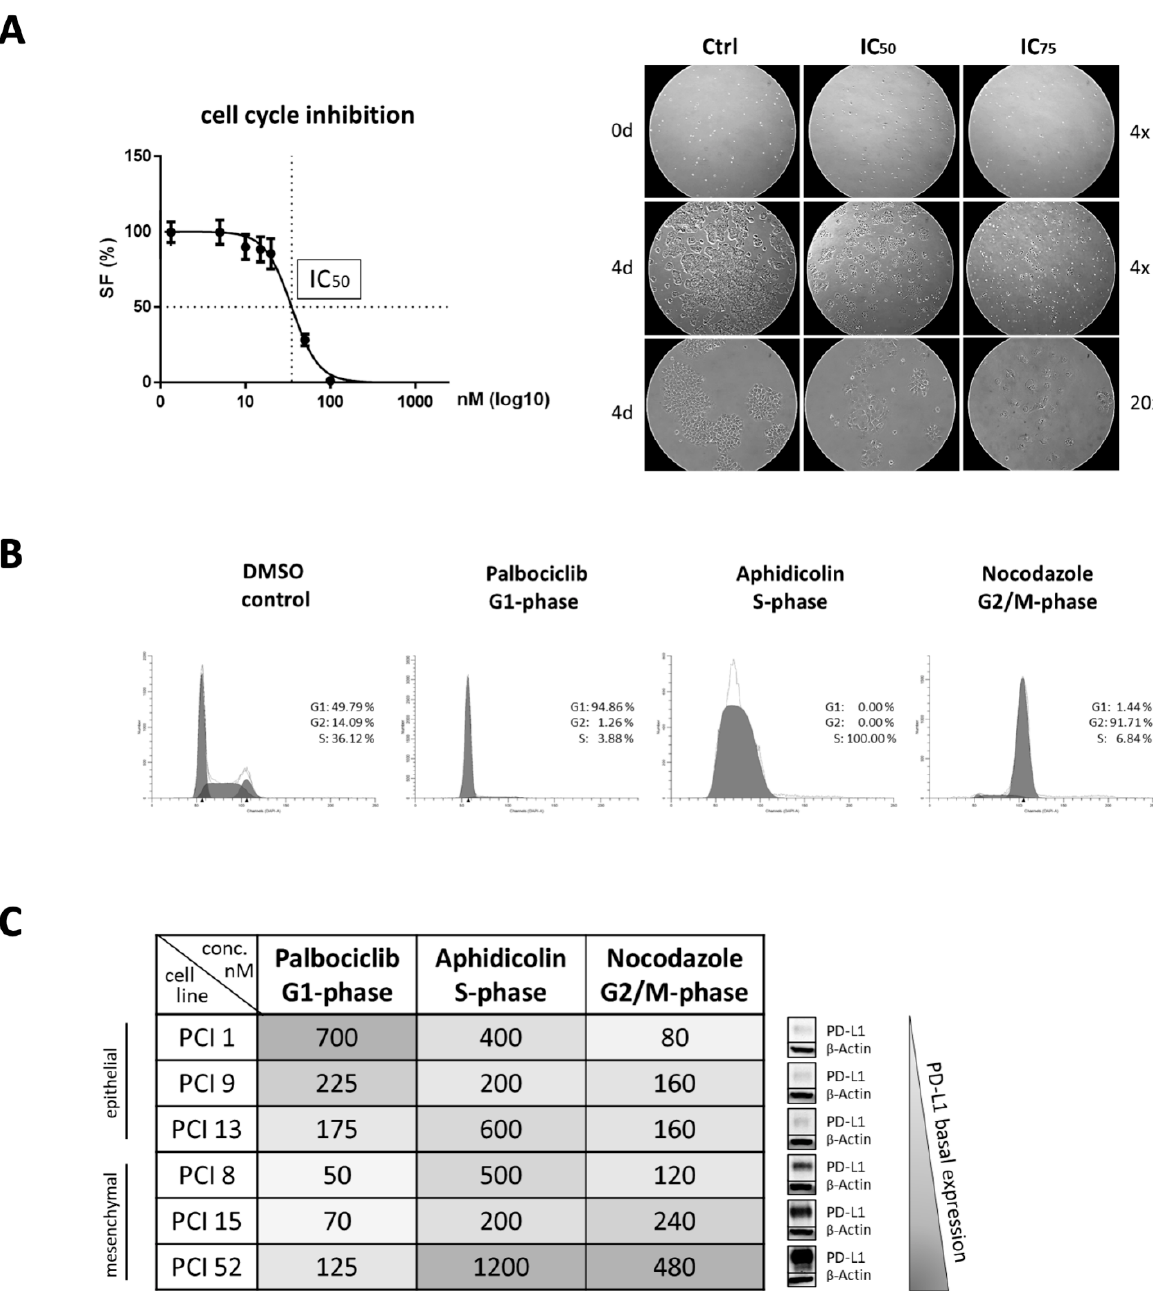
Figure 3. Efficacy of cell cycle inhibitors. ( A ) Inhibition of cell proliferation due to the incubation with cell cycle inhibitors. An MTT viability assay was used for IC 50 determination. Here, PCI 1 was chosen as the representative cell line with nocodazole (G2/M phase) treatment. Photo documentation after four days of inhibitor treatment confirmed the inhibition of cell proliferation. PCI 13 was chosen as the representative cell line with aphidicolin (S phase) treatment. Images are shown at four- and 20-fold magnification. ( B ) Cell cycle analysis via flow cytometry after inhibitor treatment. Flow cytometry confirmed that palbociclib treatment resulted in G1 phase, aphidicolin in S phase, and nocodazole in G2/M phase arrest. Here, PCI 13 was also chosen as the representative cell line. Incubation with DMSO instead of a specific inhibitor were used as controls. To quantify the DNA content, cells were incubated with DAPI. For analysis 5 × 10 4 cells were used per sample. The proportion of cells in a particular cell cycle phase is expressed as a percentage (%). ( C ) Effective concentrations of cell cycle inhibitors. Concentrations for palbociclib, aphidicolin, and nocodazole are listed in nanomolar (nM). High concentrations are highlighted in dark, whereas low concentrations are highlighted in light colors. Cell lines were subdivided into their epithelial and mesenchymal differentiation status and ranked according to their PD-L1 basal expression.